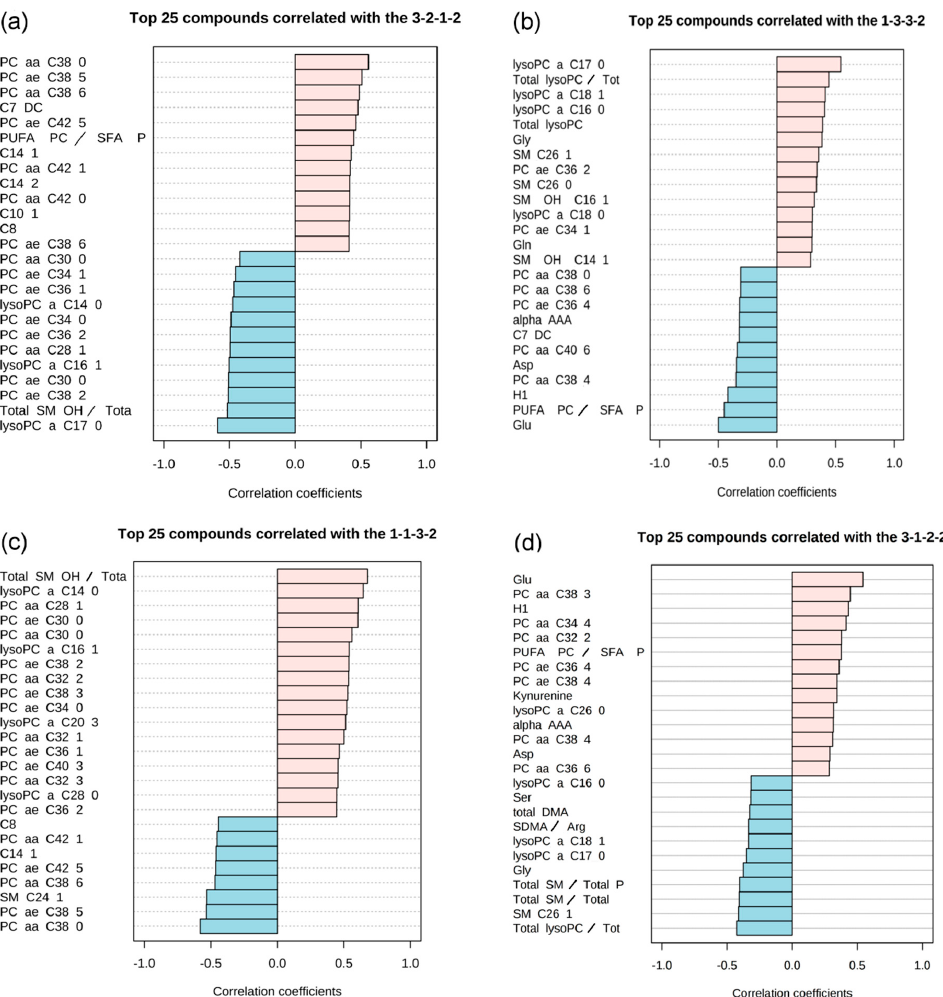
Figure 1. Selected examples of pattern hunter profiles presenting metabolites and their match with the tested pattern. The single images show both positively correlated (in light pink) and negatively correlated (in light blue) metabolites within a vertical bar graph: ( a ) pattern group 3-2-1-2 (HC, T 0 , T 1 ,T 2 ); ( b ) pattern group 1-3-3-2 (HC, T 0 , T 1 ,T 2 ); ( c ) pattern group 1-1-3-2 (HC, T 0 , T 1 , T 2 ); ( d ) pattern group 3-1-2-2 (HC, T 0 , T 1 , T 2 ), 1 < 2 < 3 = relative metabolite concentrations; HC = healthy controls, T 0 = admission, T 1 = half of target weight, T 2 = long-term weight gain close to target weight. Abbreviations see Human Metabolome Database (HMDB) ist: http://www.hmdb.ca/ [42]; correlation coefficient: non-parametric Spearman correlation coefficient of log-transformed measurements.